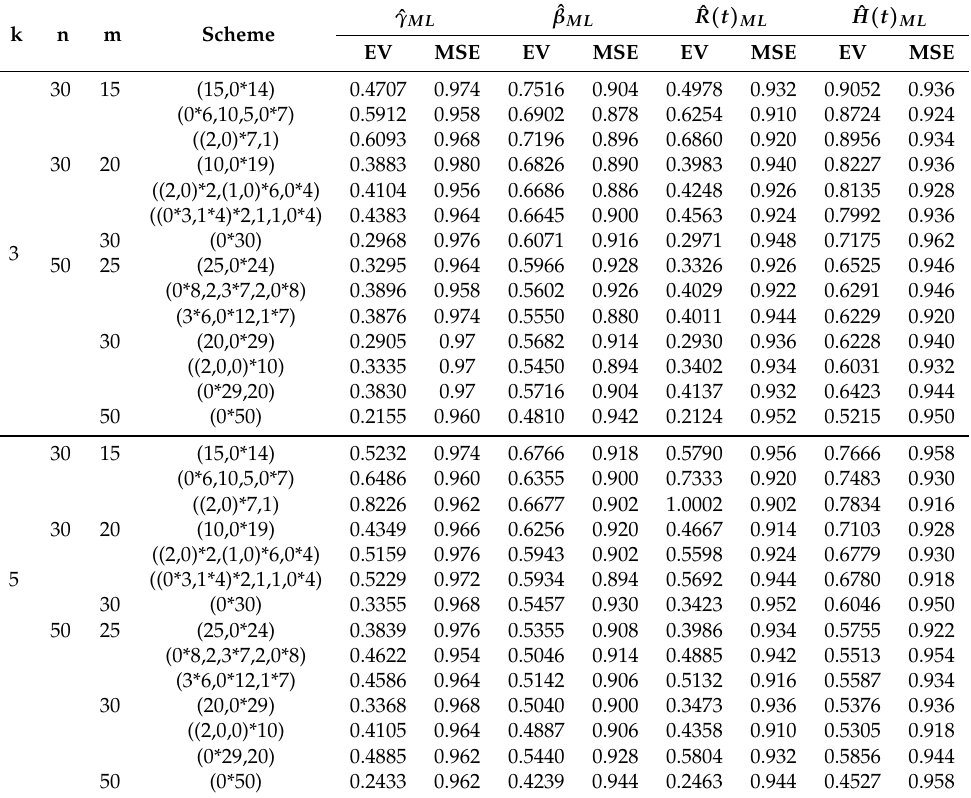
Table 19. Average length and coverage probability of 95% asymptotic confidence/Bayesian credible interval for parameters under SELF when γ = 0.3, β = 0.8, t = 1.5, a 1 = 1.08, b 1 = 3.6, a 2 = 16, b 2 = 20, N =